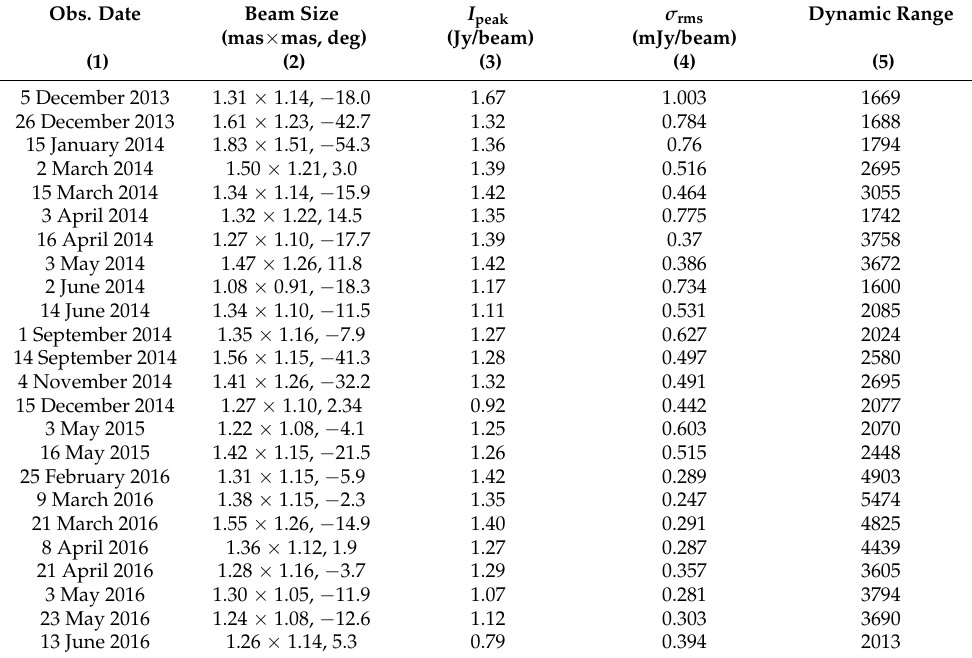
Table A1. Summary of KaVA 22GHz observations of the M87 jet from December 2013 to June 2016. Obs. Date Beam Size I peak σ rms Dynamic Range (mas × mas,